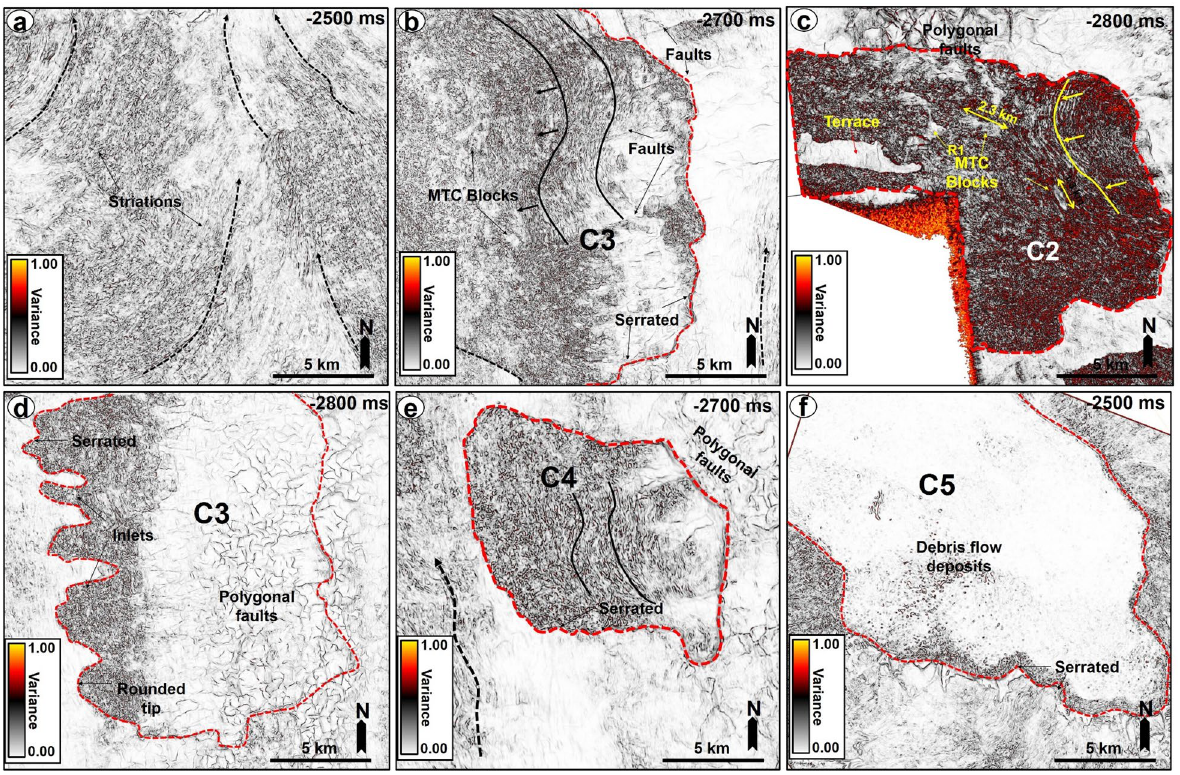
Figure 8. Variance maps showing orientation of striations, an outline of the craters, and compositional variations in strata filling the craters. ( a ) N- to NW oriented striations at the base of MTC X in the Solsikke area. The craters are characterized by chaotic dark, grey, and heterogeneous reflections on the variance maps, whereas the terraces are white to reflection-free sections that contrast sharply with the adjacent craters. The variance maps also reveal that the internal and external geometries of the craters include ( b ) slide blocks from the SMA area ( c – e ) Serrated distal inlets with slide blocks, faults, and slump folds in the Havsule area and ( f ) Chaotic reflections akin to debris-flow deposits within C5. R1- Rafted block